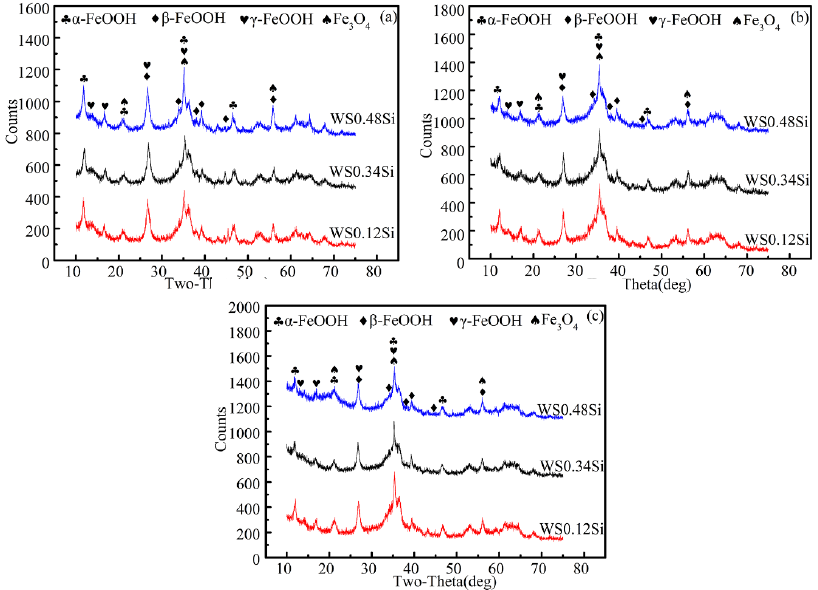
Figure 3. X-ray diffraction patterns of three experimental steel groups at ( a ) 6th cycle, ( b ) 30th cycle, and ( c ) 120th cycle.